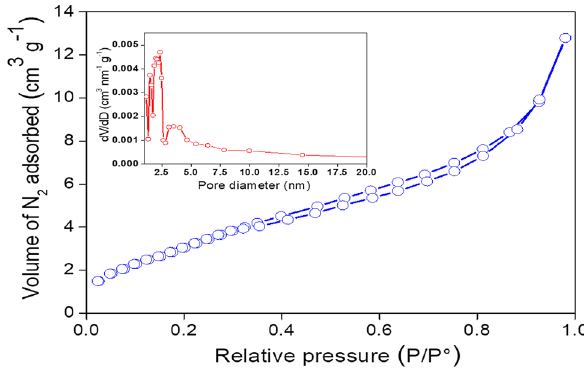
Fig. 6 Nitrogen adsorption–desorption isotherm of B-TiO [inset: pore size distribution]